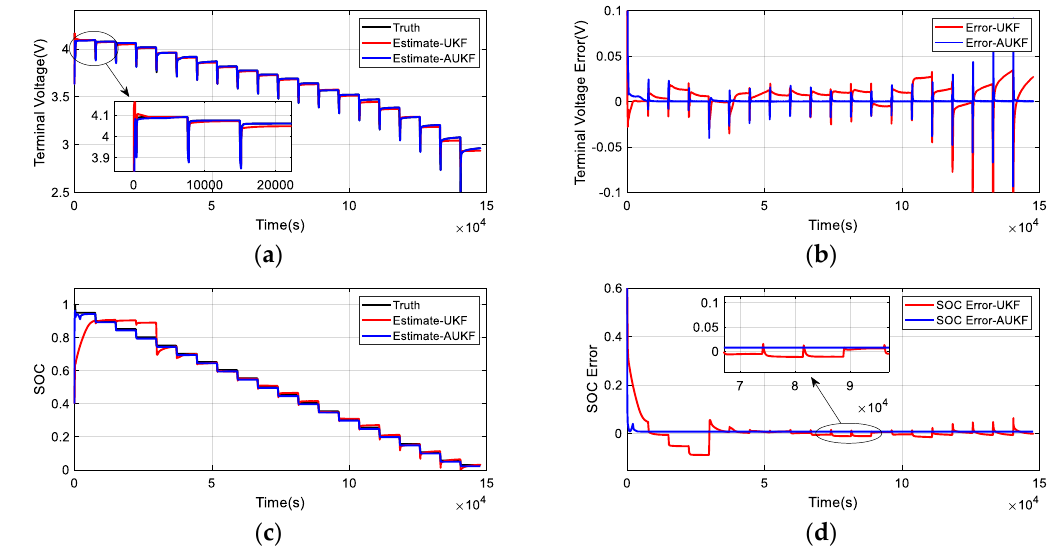
Figure 14. For the initial SOC = 0.4, the comparison of the estimation results of the UKF algorithm and the AUKF algorithm under pulsed discharge conditions. ( a ) Comparison of terminal voltage. ( b ) Comparison of terminal voltage errors. ( c ) Comparison of SOC. ( d ) Comparison of SOC errors.